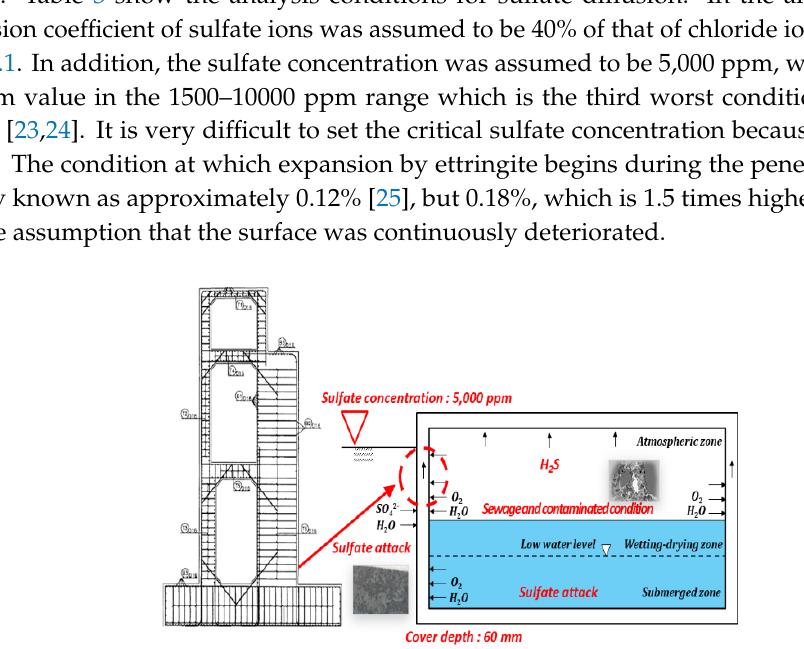
Table 3. Analysis conditions for sulfate diffusion. 186